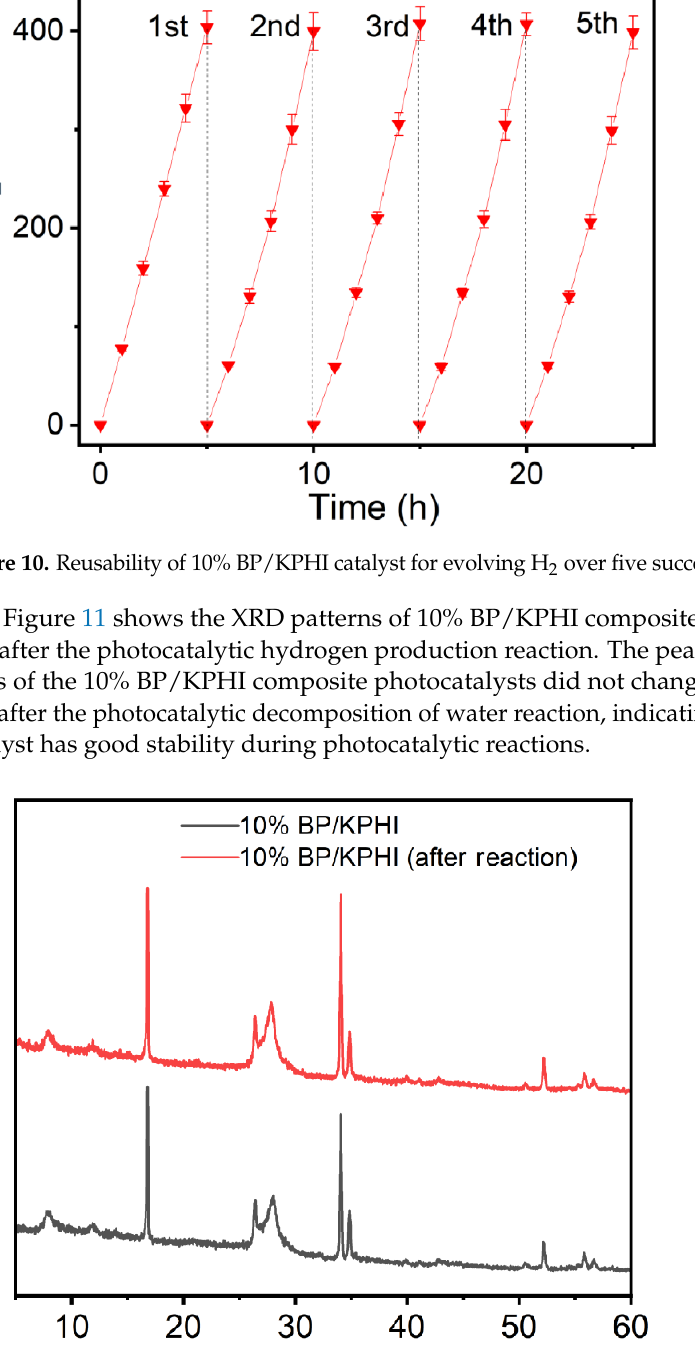
Figure 9. Wavelength-dependent AQYs of photocatalytic H 2 production and the corresponding UV-vis DRS spectrum for 10% BP/KPHI.